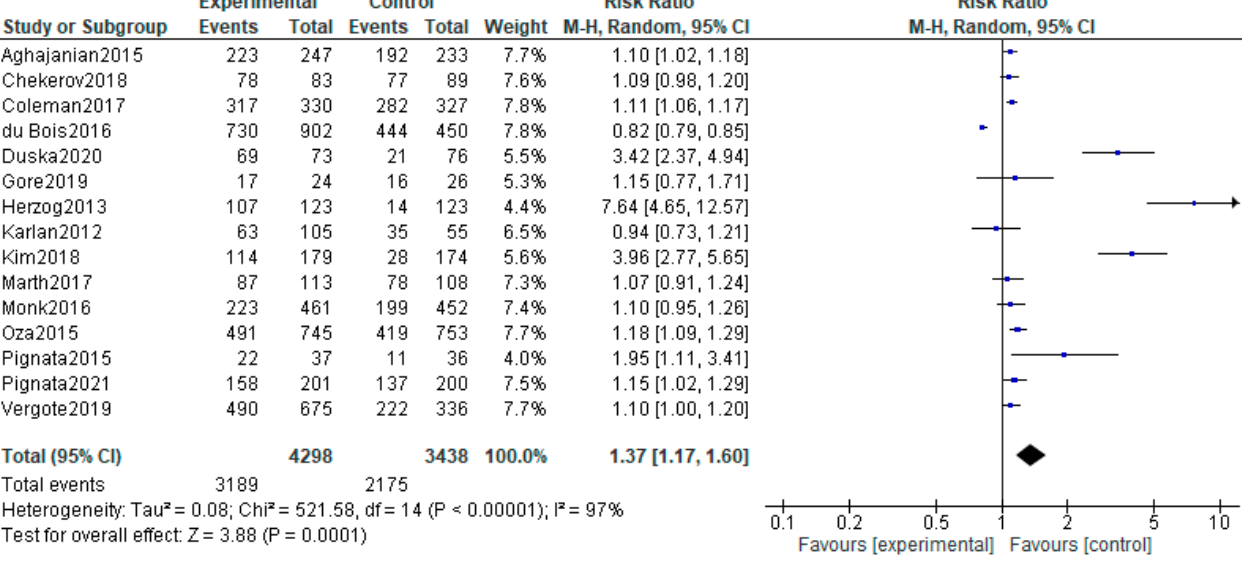
Figure 7. Grade ≥ 3 adverse effects associated with antiangiogenetic therapy. The black diamonds are visual representations of pooled effect and its confidence intervals and are non-significant if they overlap 1. Blue squares represent each study effect size and study weight (size of square). The lines represent each study confidence interval [26–30,32,34–36,41–45,52].